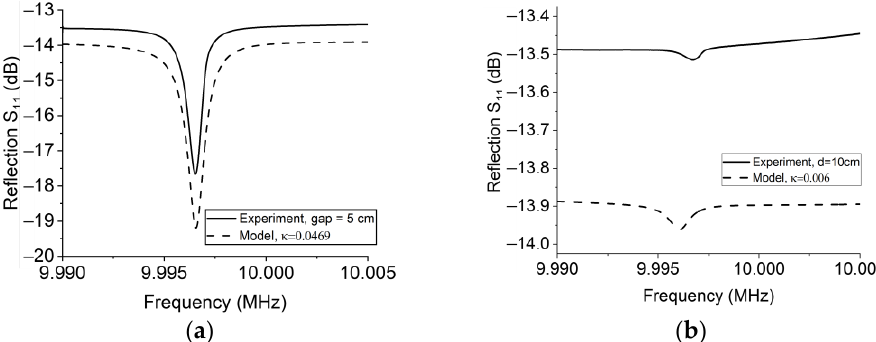
Figure A3. The comparison between experimental results and analytical solutions for different gaps. After we find the relationship between the coupling coefficient and the separation distance, we can compare the experimental result with the corresponding analytical results. ( a ) 5 cm. ( b ) 10 cm.